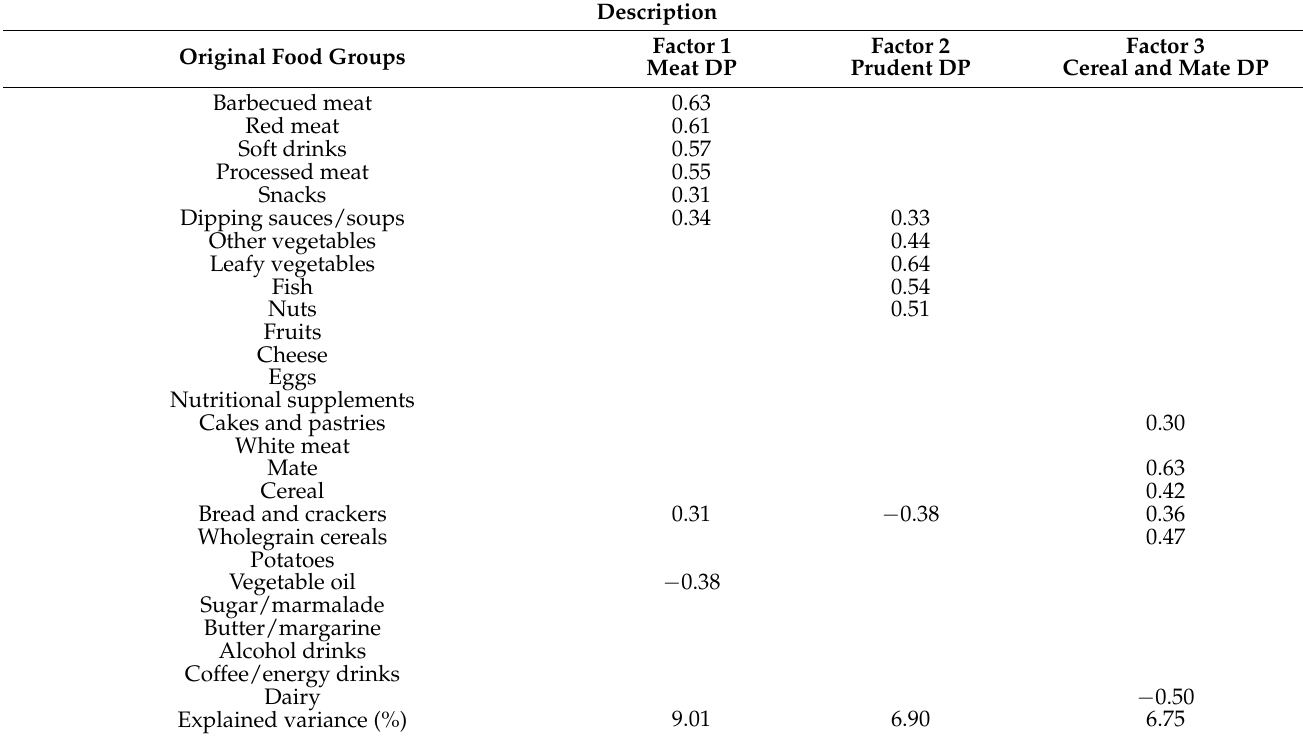
Table 1. Factor-loading matrix characterizing the three dietary patterns derived from the 27 food items in Uruguayan adults 1